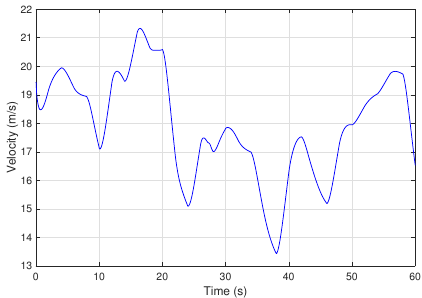
Figure 11. Velocity of the vehicle.